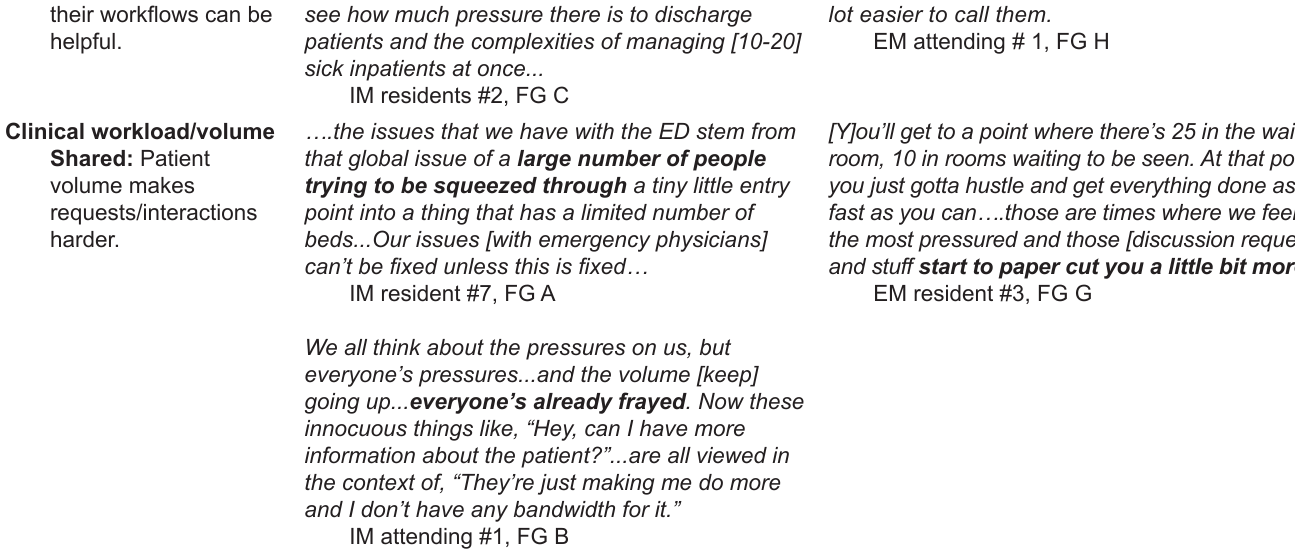
* Bolded sections added for